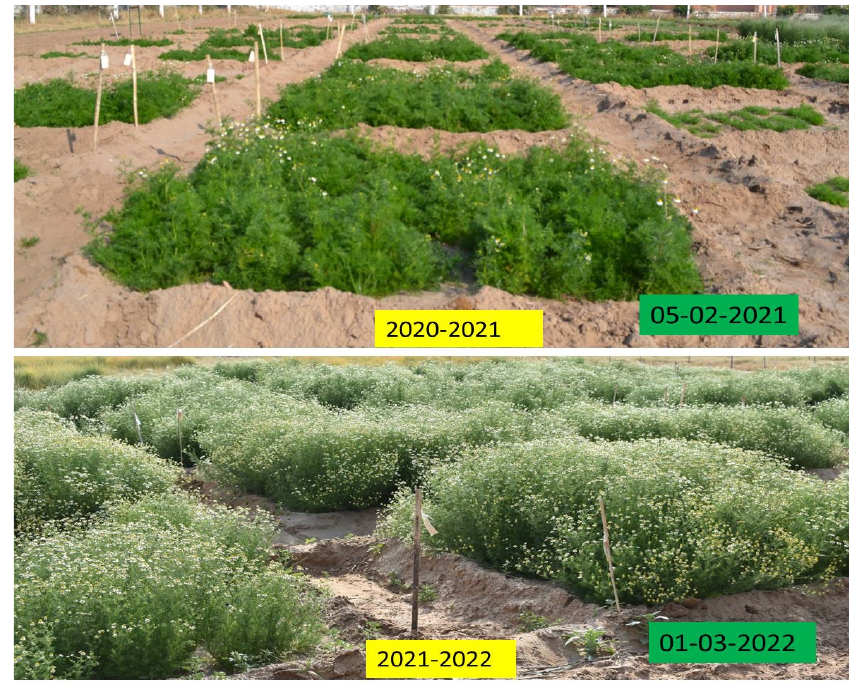
Figure 1. Chamomile ( Matricaria chamomilla L.) field trial during experimental years 2020–2021 and 2021–2022.